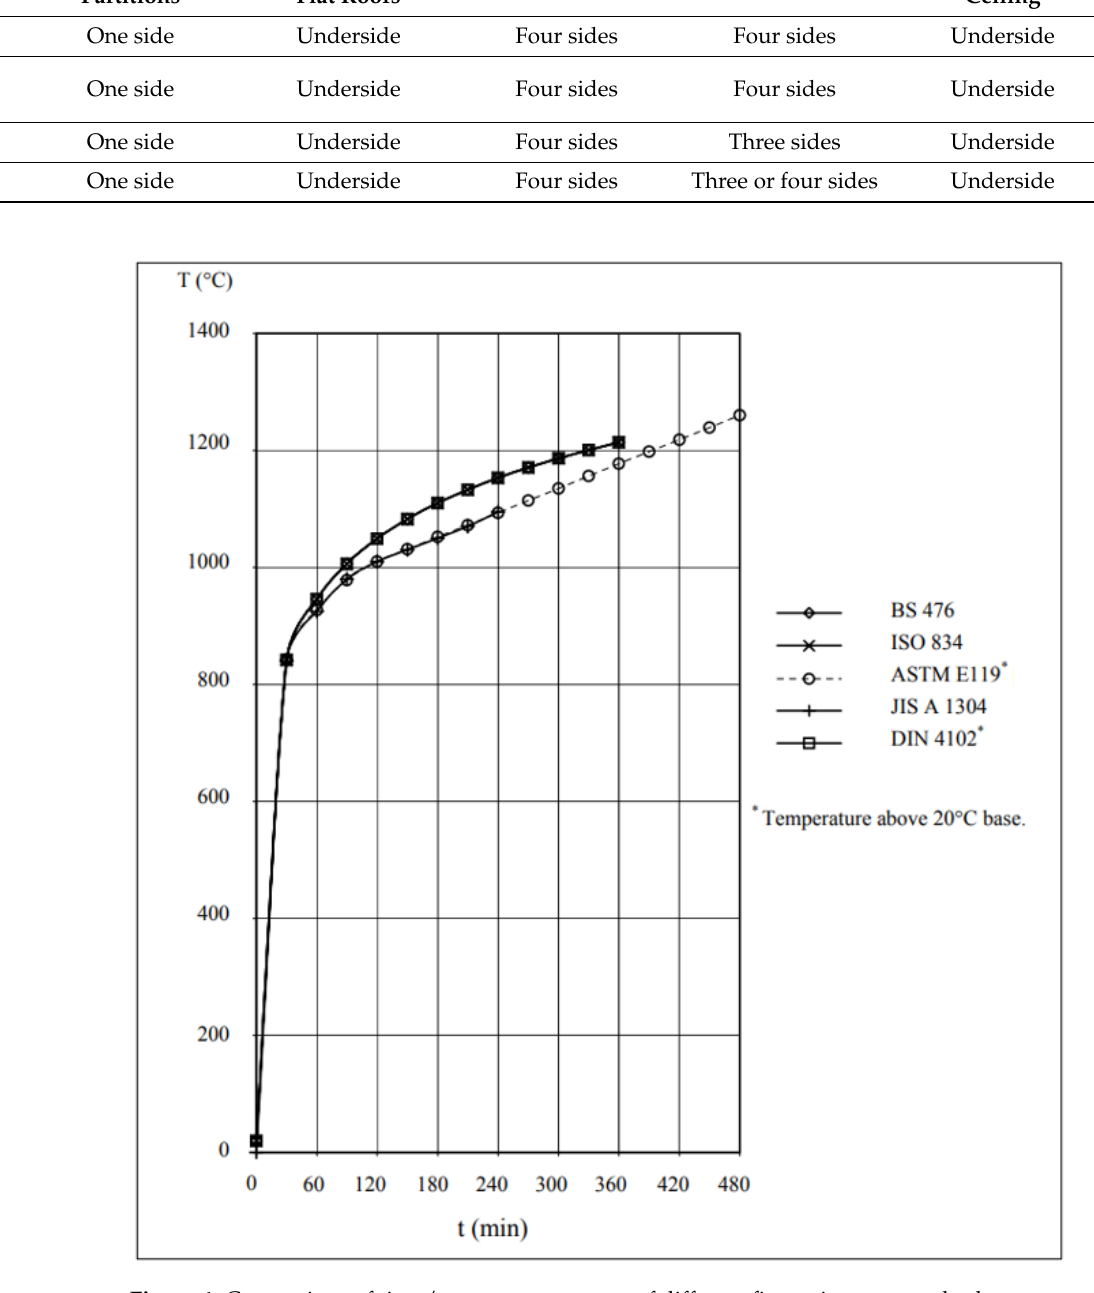
Figure 4. Comparison of time/temperature curves of different fire ‐ resistance standards.